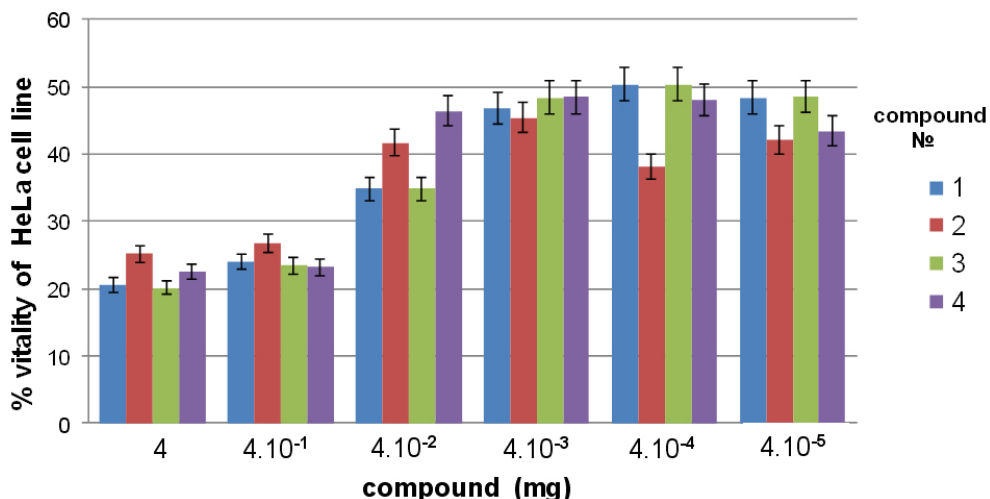
Figure 4. Vitality (%) of human epithelial cervix adenocarcinoma HeLa, treated with substances 1- 4 .